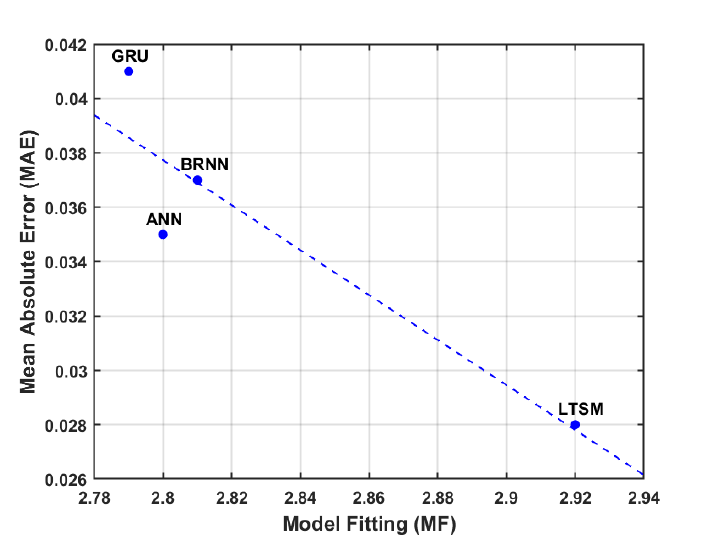
Figure 10. Mean absolute error (MAE) versus model fitting (MF) of the model ANN, LSTM, GRU and